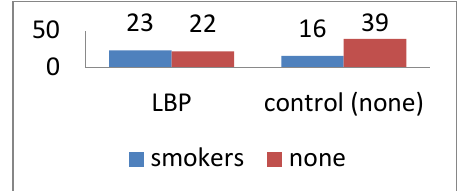
Figure 2: number of smokers in both groups.